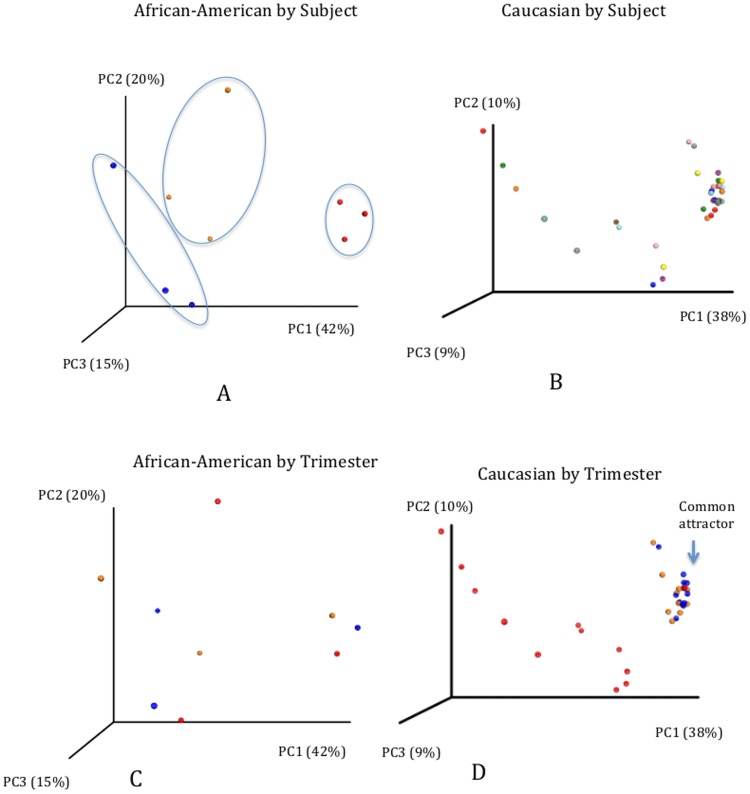
Unweighted PCA analysis by Subject and Trimester.A – African-American by Subject. Clustering by Subject can be observed. B – Caucasian by Subject. No clear clustering is observed. C – African-American by Trimester. No common attractor can be identified. D – Caucasian by Trimester. A common attractor can be observed. Plots C and D – 1st Trimester – Red; 2nd Trimester – Blue; 3rd Trimester – Orange.